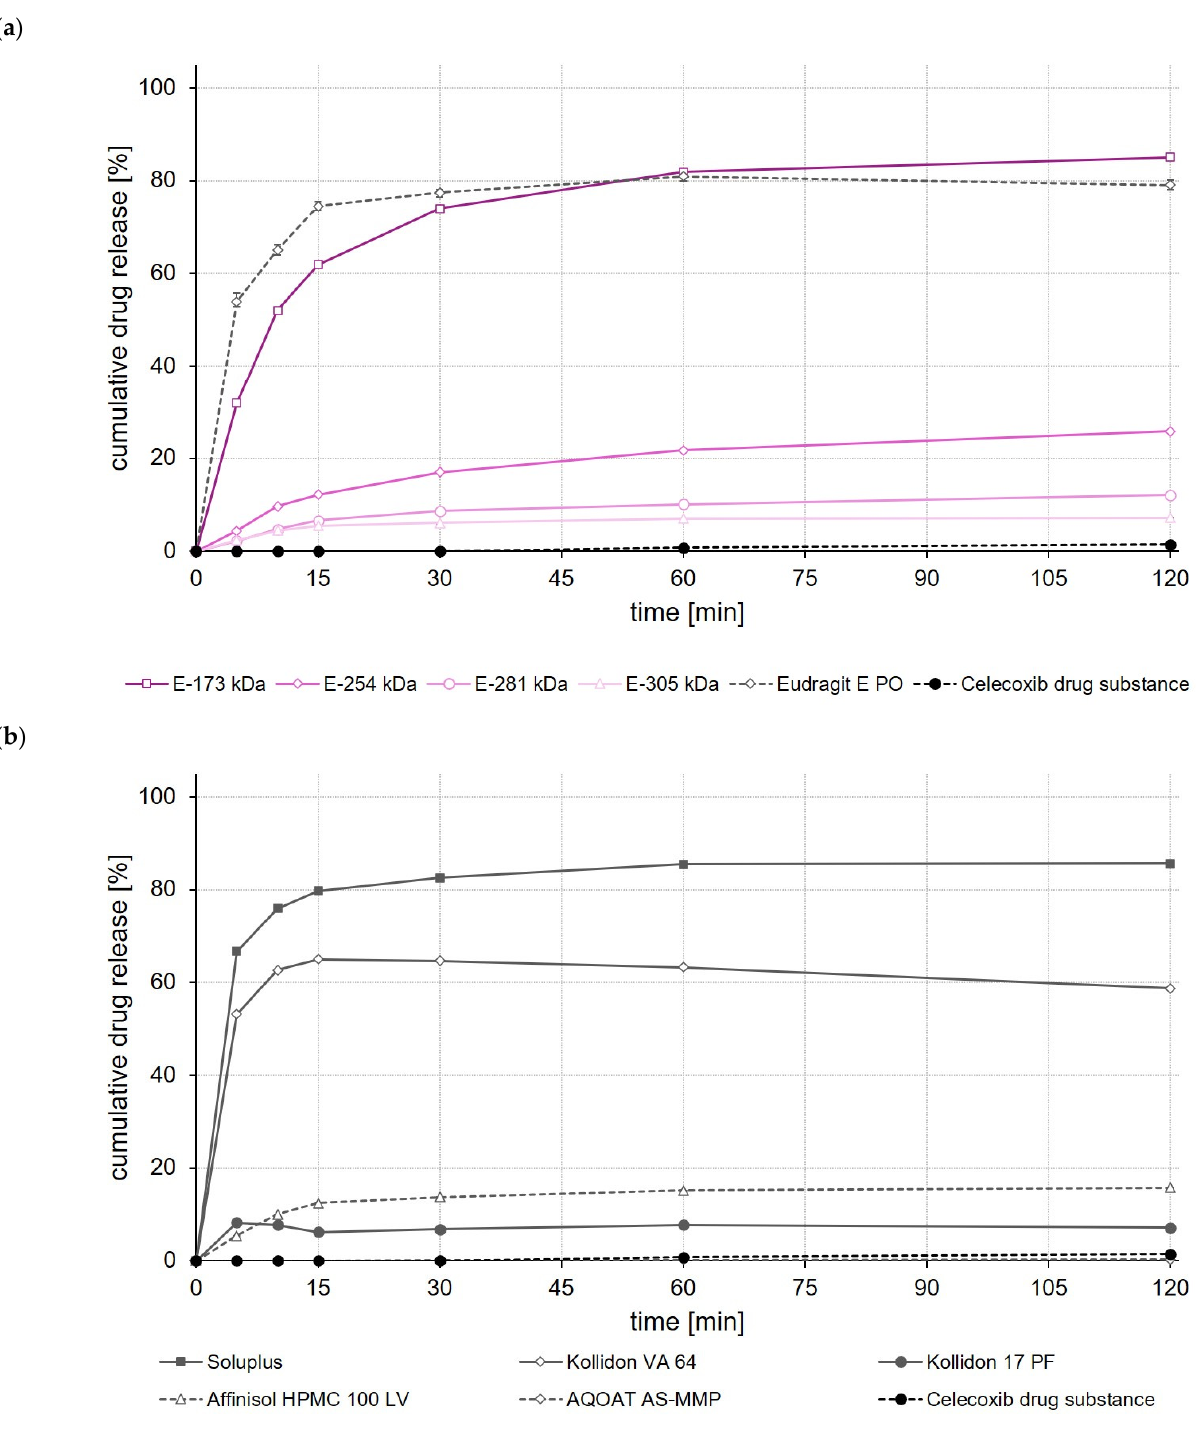
Figure 9. Dissolution profiles of celecoxib drug substance and celecoxib ASDs based on ModE and EPO ( a ), as well as celecoxib drug substance and celecoxib ASDs based on other marketed (co-)polymers ( b ) (after three months of storage at 30 °C/65% RH) in 500 mL 0.1 M HCl in USP apparatus II. Each value designates the mean ± S.D. (n = 3).